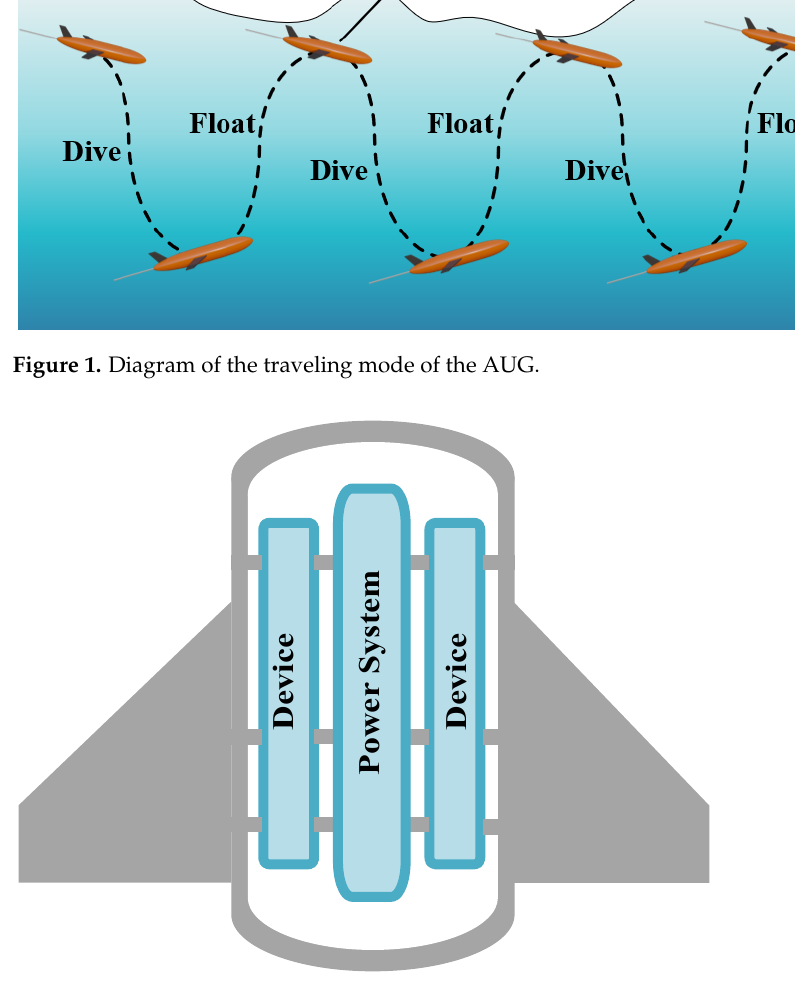
Figure 2. Diagram of the internal structural layout of the AUG.